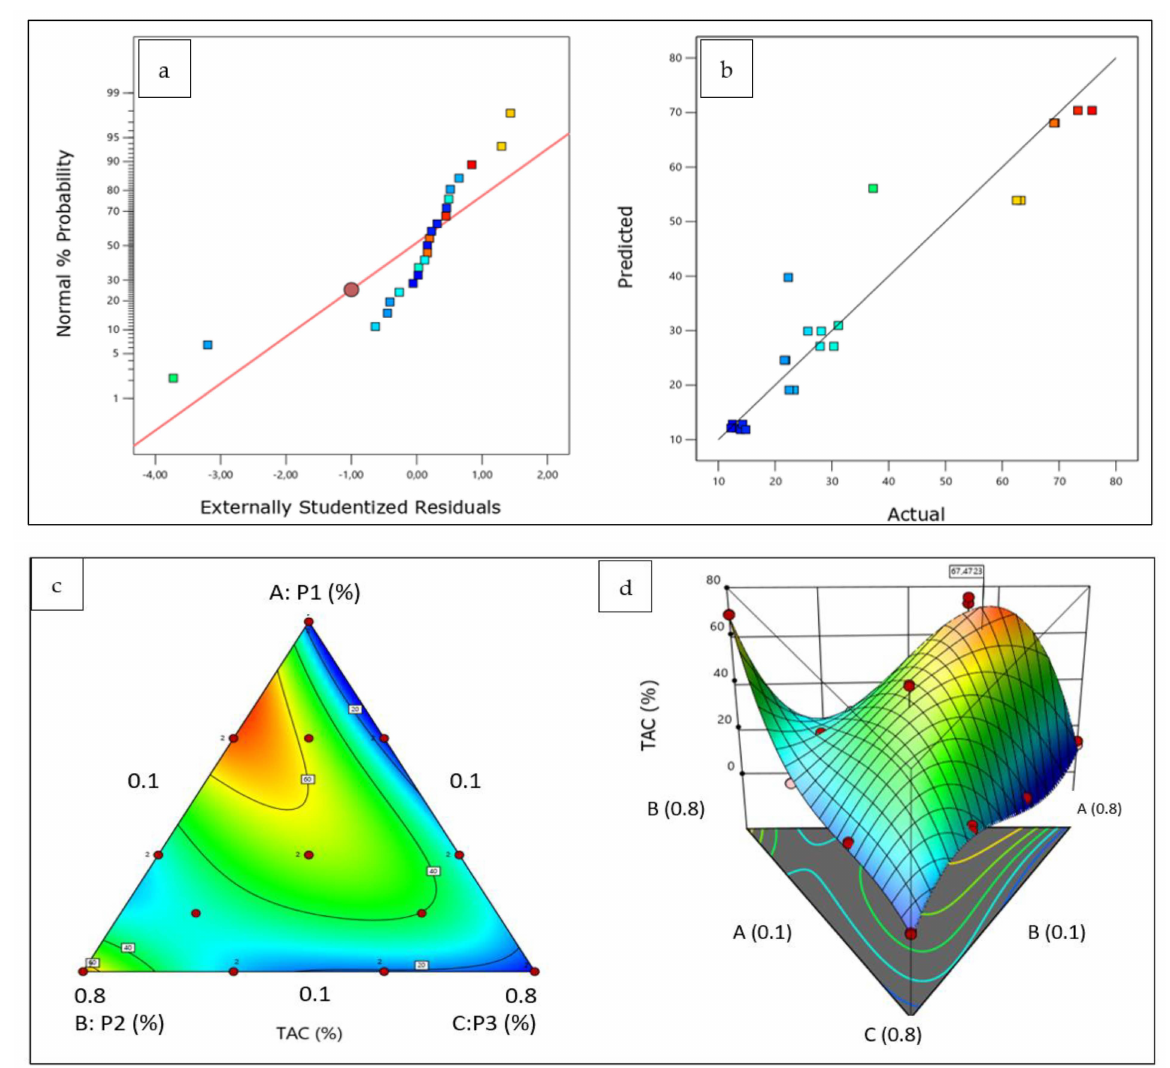
Figure 3. ( a ) Normal probability plot, ( b ) predicted versus actual plot, ( c ) contour plot, and ( d ) 3D surface plot of the effect of the three components on TAC